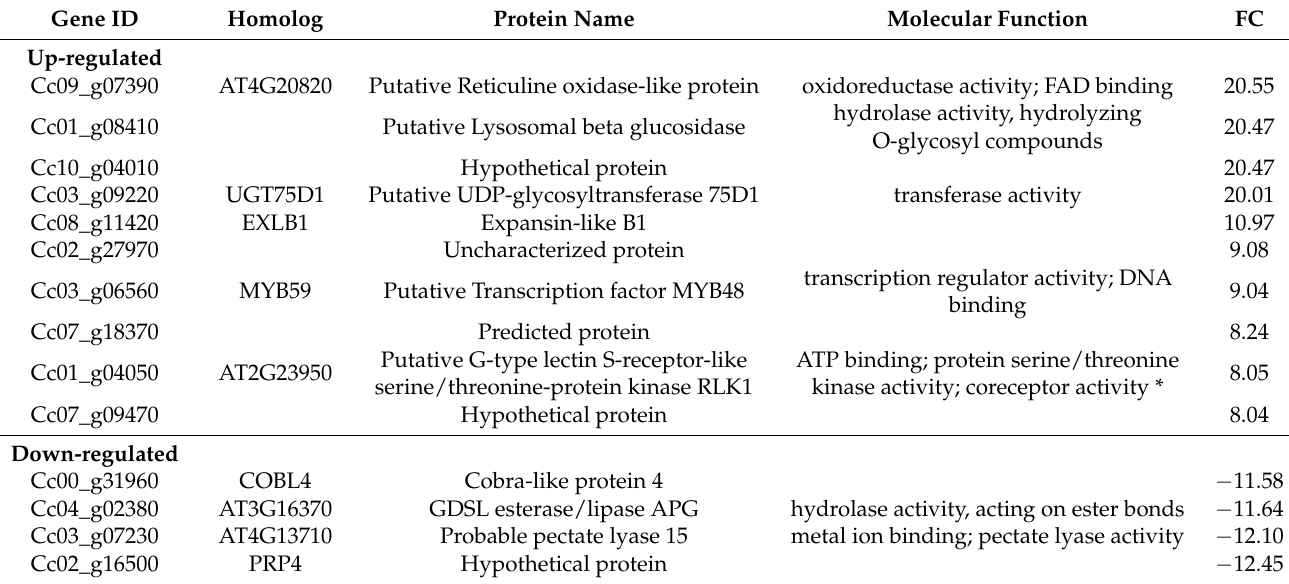
Table 4. Top 10 up and down-regulated differentially expressed genes (DEGs) under severe water deficit (SWD) relative to well-watered (WW) Coffea arabica cv. Icatu (Icatu) plants. Molecular functions were retrieved from UniprotKB database (* functions exclusive to A. thaliana homologs). Genes are sorted by FC in descending